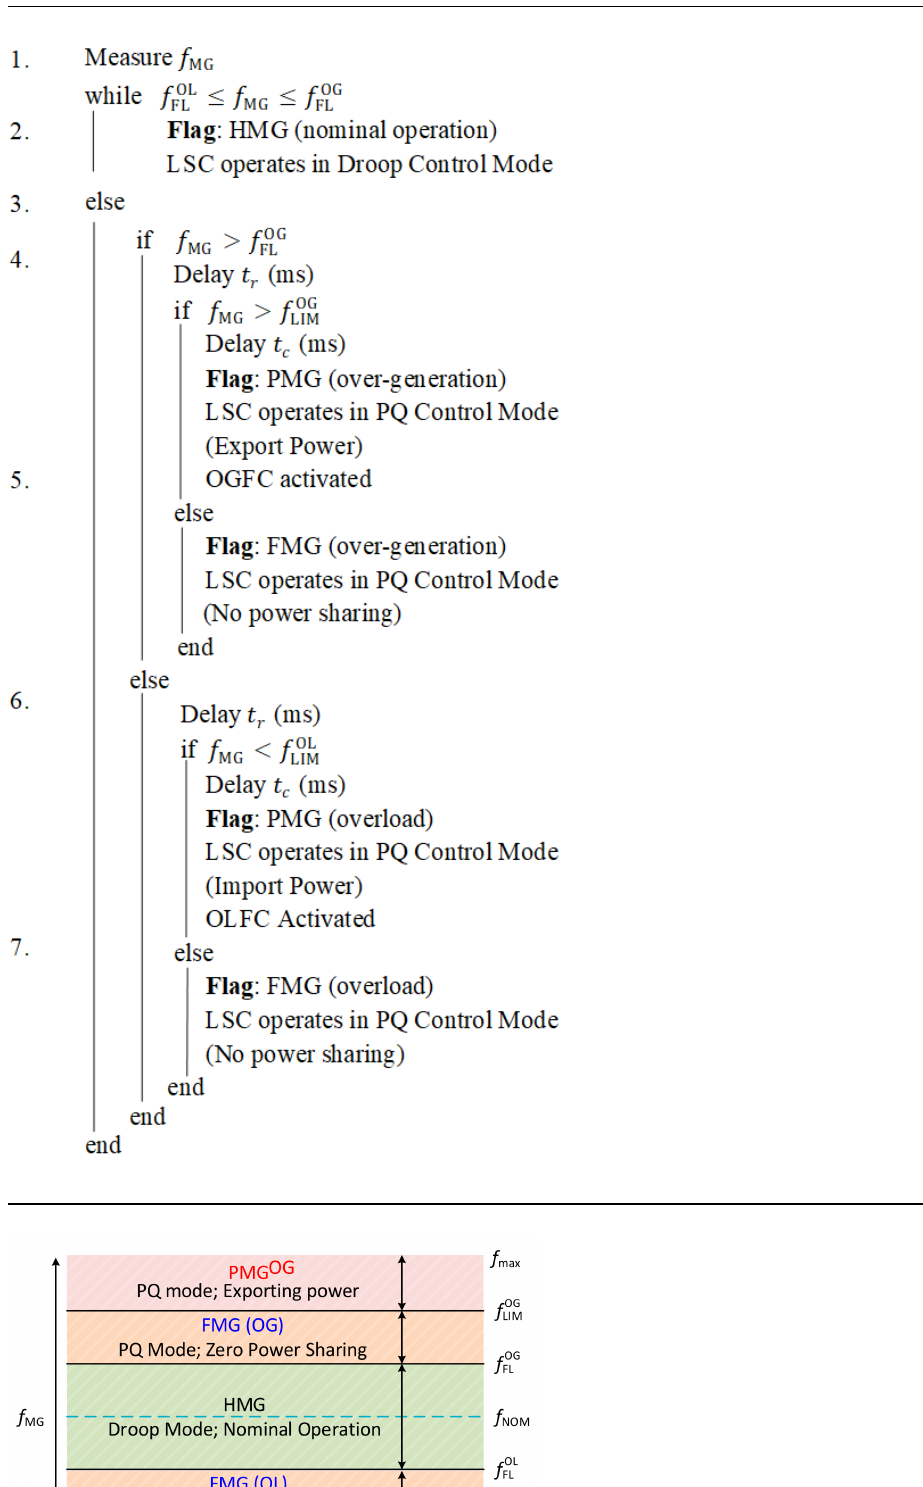
Figure 3. MG status and its different operating modes based on its frequency range. Algorithm 1: MG status detection and LSC mode of operation.